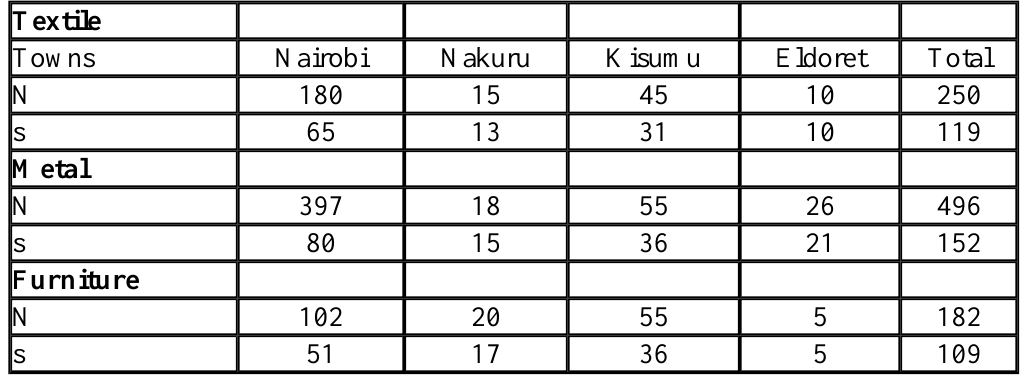
Table 1 Sample size distribution [N = 940; s = sample